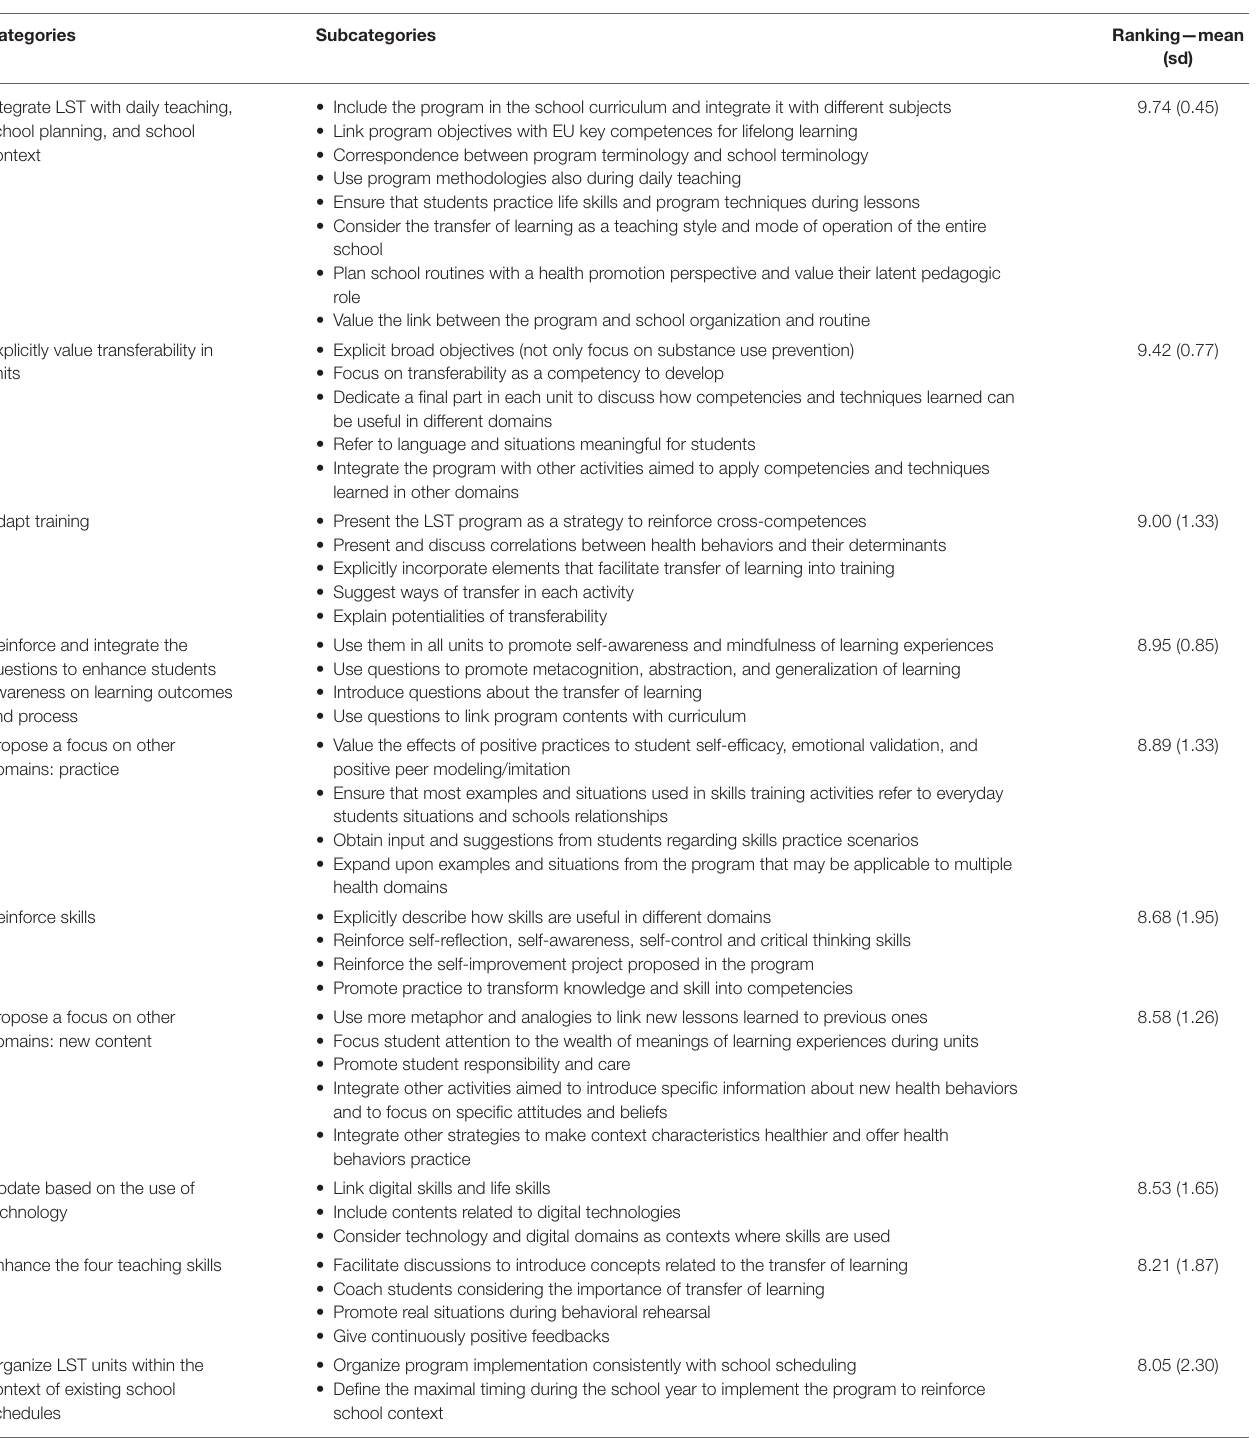
TABLE 4 | Strategies to facilitate the transfer of learning to different health behaviors and a ranking of their